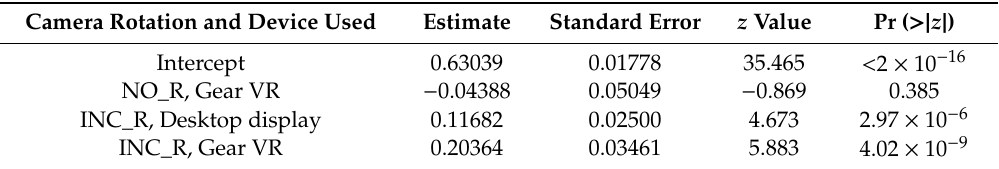
Table 22. Logistic regression analysis results, investigating the pair of camera rotation and the device used.